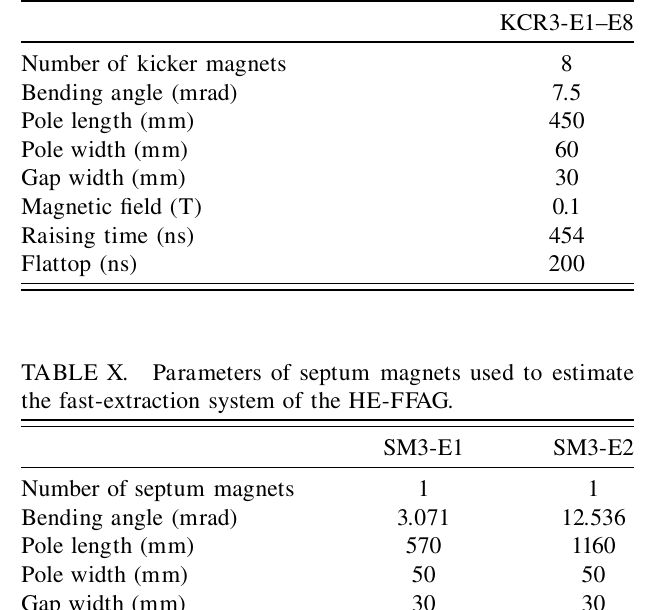
FIG. 11. Frequency dependence of the cavity impedance (cid:5) R (cid:1) jX ) for the LE-FFAG ring. Here, four cores ( Z cav cav cav per cell and a gap capacitance of 70 pF are assumed.